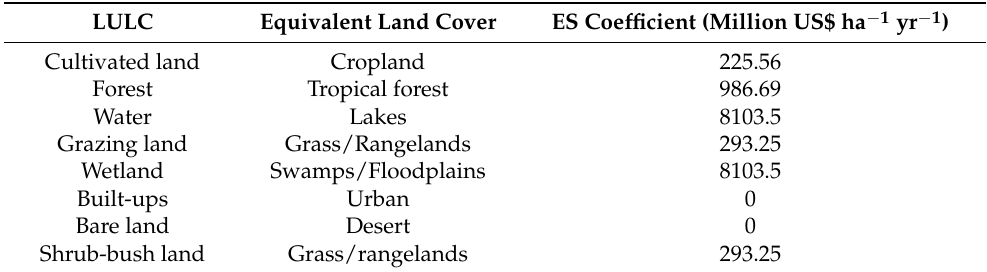
Table 2. Modified ES value coefficients (million US$ ha − 1 yr − 1 ) for LULC equivalents land